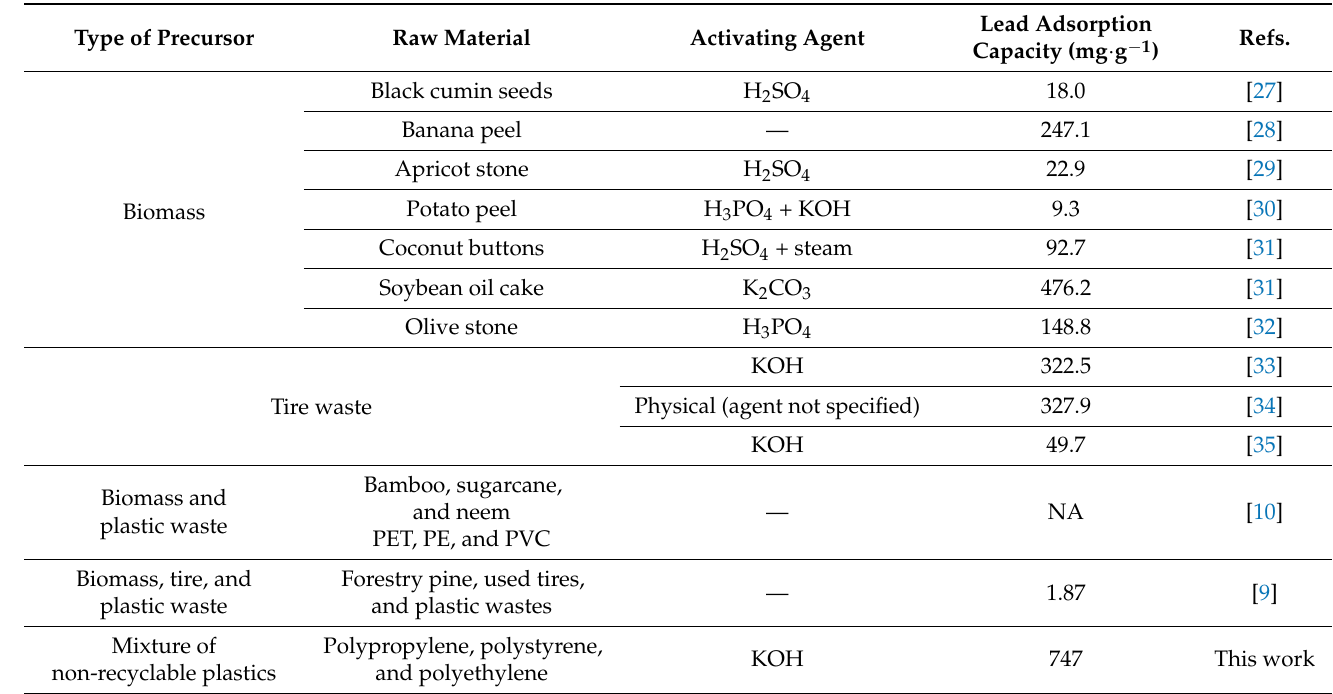
Table 5. Some published works about lead adsorption by activated carbons obtained from char of pyrolysis of different precursors